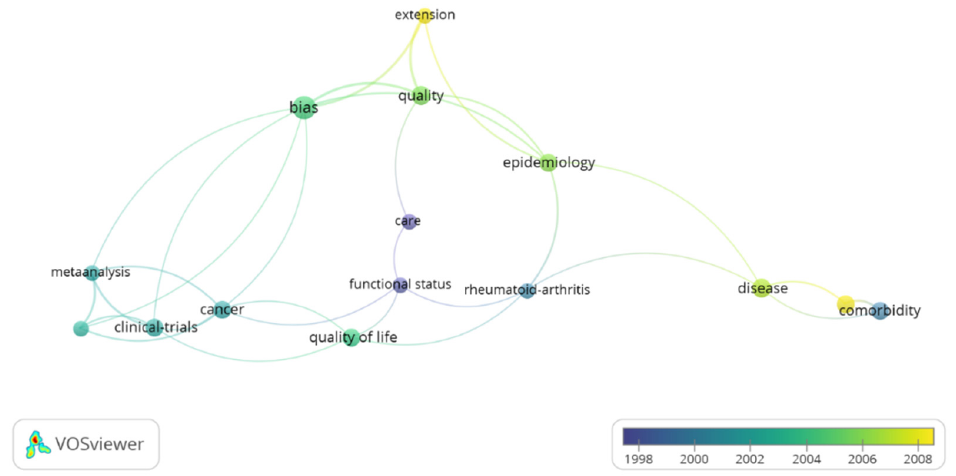
Figure 3. The co-occurrence network of keywords. Note : The size of the nodes indicates the fre- quency of occurrence. The curves between the nodes represent their co-occurrence in the same pub- lication. The smaller the distance between two nodes, the higher the number of co-occurrence of the two keywords.